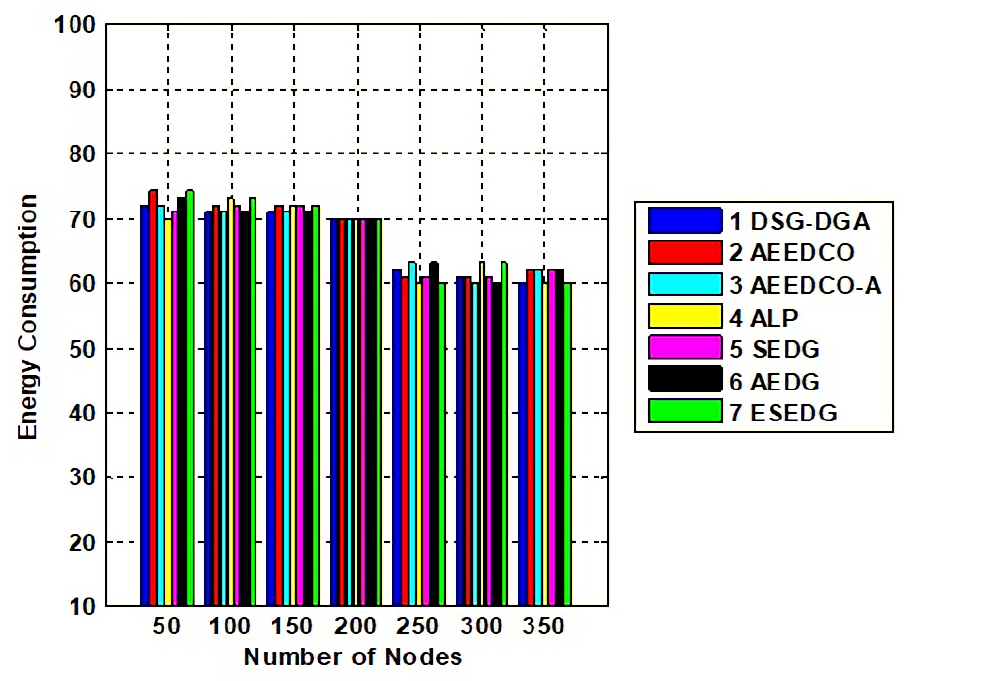
Figure 11. Analysis of network energy consumption with baseline